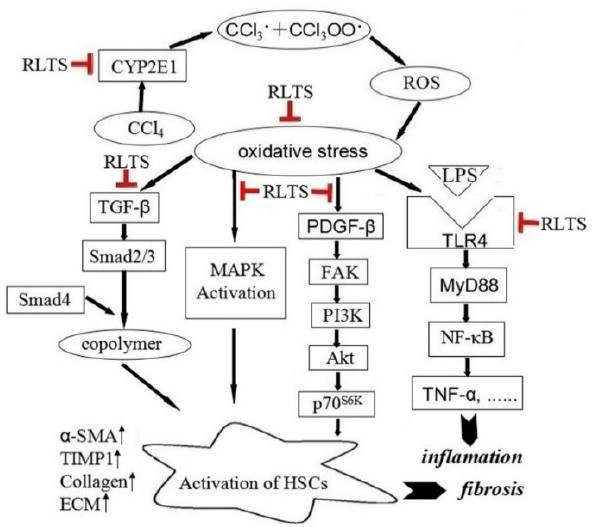
Figure 8. Rosa laevigata Michx fruit (RLTS) down-regulated collagen expression, reduced extracellular matrix (ECM) accumulation, decreased CYP2El activity, attenuated oxidative stress, suppressed inflammation, inhibited hepatic stellate cells (HSCs) activation via TGF-β/Smad, FAK-PI3K-Akt-p70 S6K and MAPK signaling